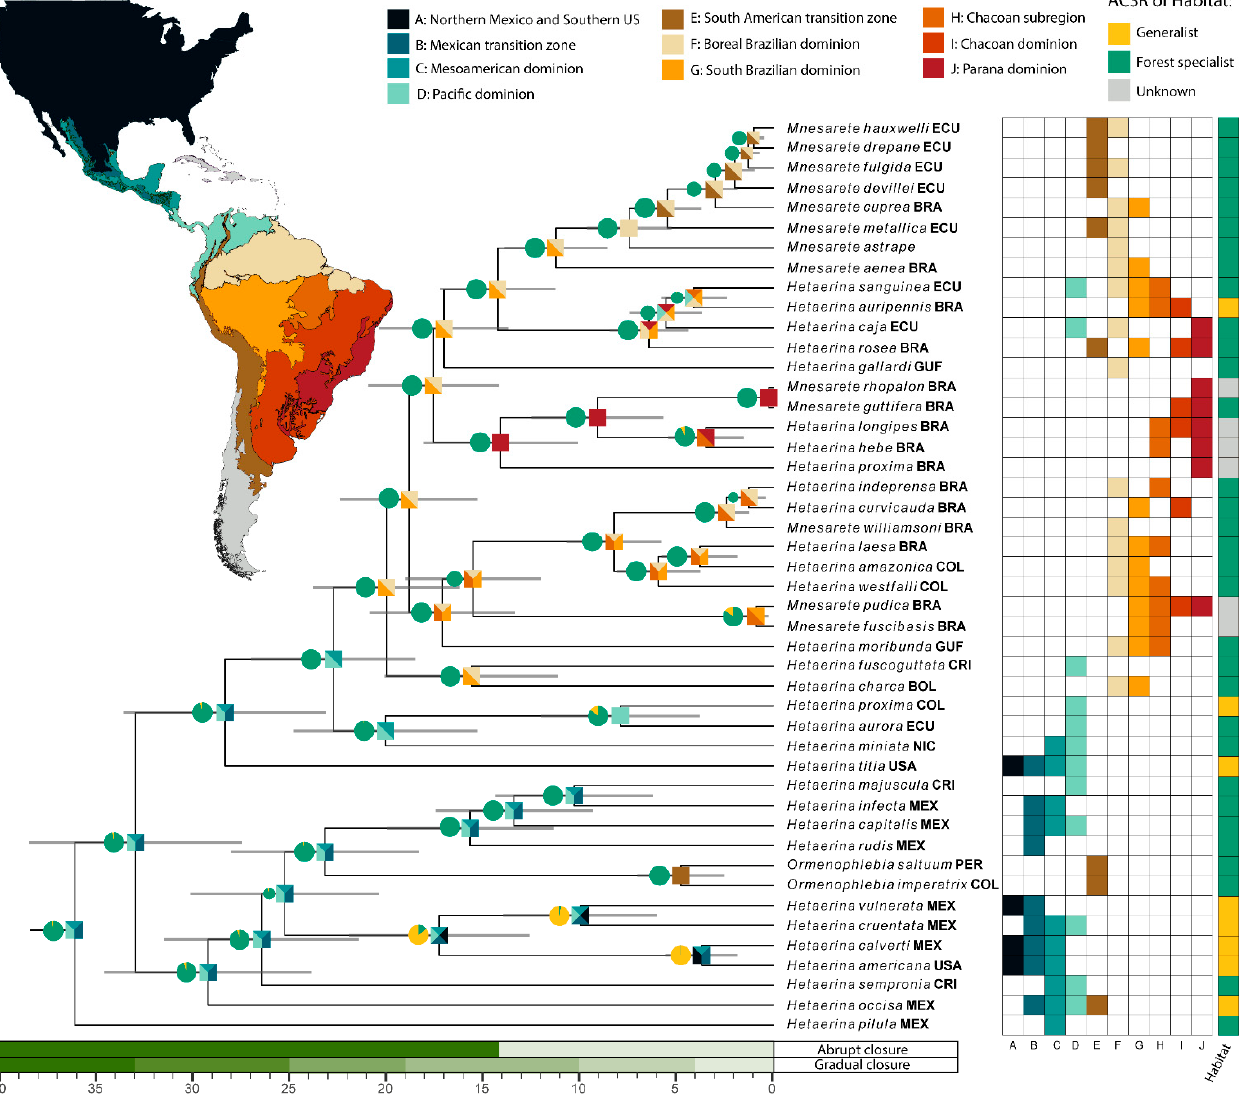
Figure 3. Hetaerininae biogeography analysis on time-calibrated phylogenetic tree. Biogeographic analysis conducted in BioGeoBEARS v1.1.2 with a maximum range size of six. Bayesian time- calibrated tree estimated in BEAST2 v2.6.6. Color-coded matrix corresponds with current species distribution. Squares at nodes represent the ancestral range with the highest probability from the Pliocene BAYAREALIKE +J analysis. Likelihood of dispersal between Central and South America for two hypotheses (abrupt Middle Miocene closure and gradual closure) shown. Dark green represents low likelihood of dispersal, light green easy dispersal. Map based on Morrone et al., 2022 area map [50]. Pie charts represent ACSR of habitat, generalist or forest specialist. Far right column on matrix corresponds to character states coded for ACSR of habitat.